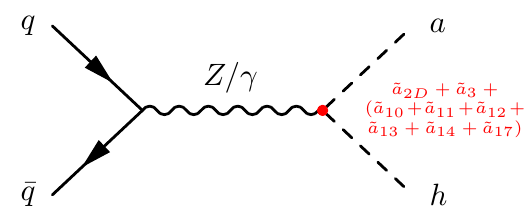
logically dominant, as the other coefficients enter the coupling with an extra suppression. The compact notation ˜ a i ≡ c i a i , ˜ b i ≡ c i b i has been